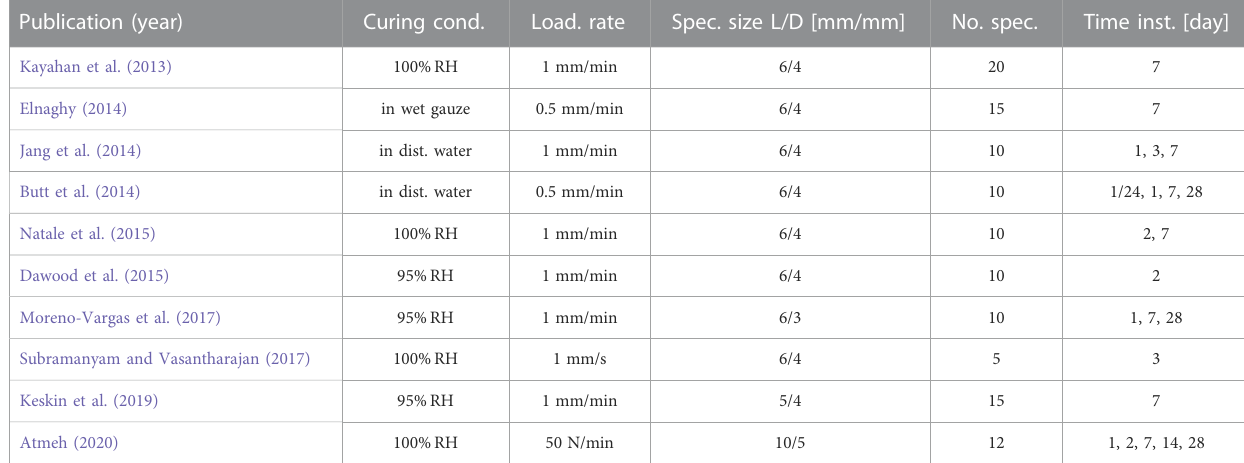
TABLE 1 Overview of details regarding the compressive strength data illustrated in Figure 1. Curing